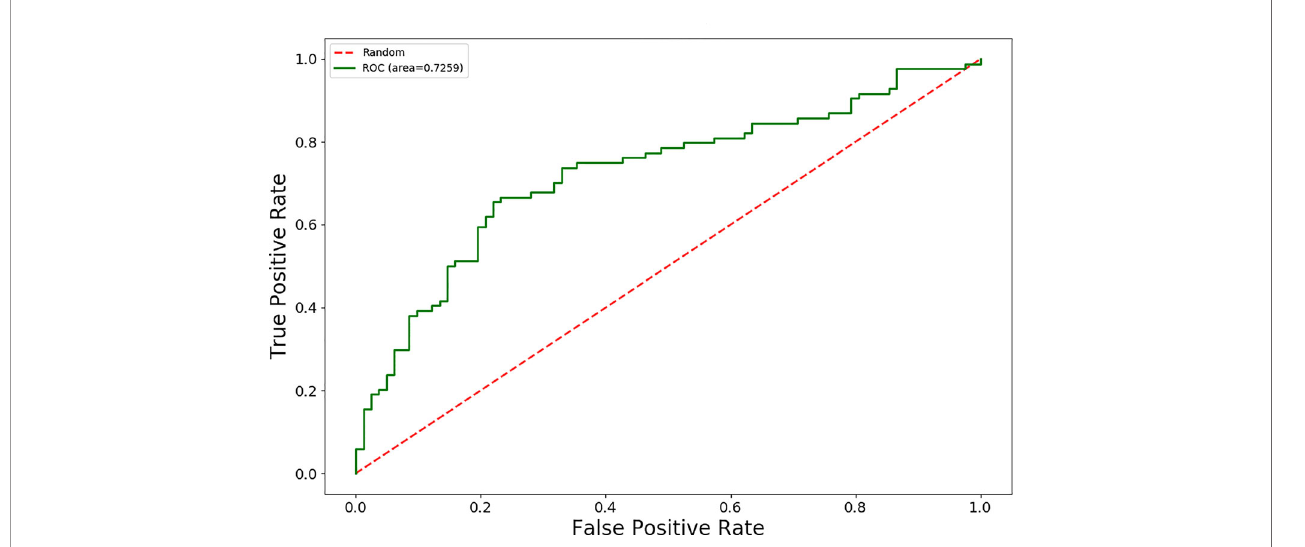
FIGURE 4 | The ROC curves of the radiomics signature in the external validation set.